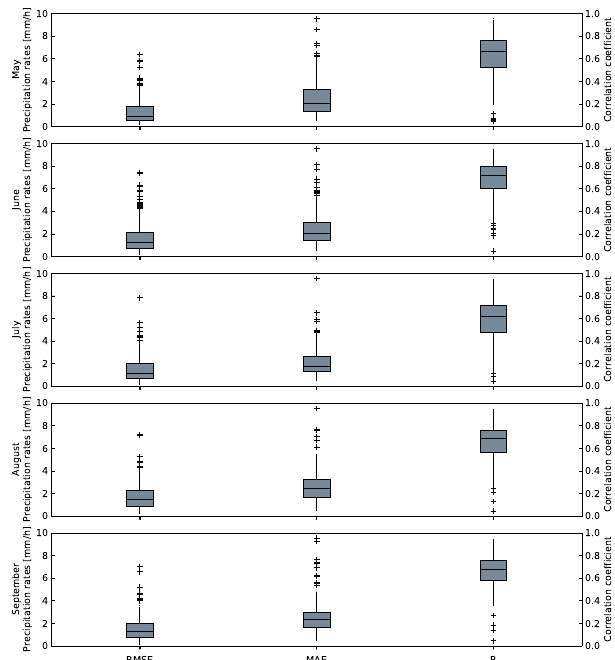
Figure 5. Performance of the validation of predicted precipitation rates against the gauge calibrated MW precipitation rates as boxplots. Validation measures RMSE, MAE (left y -axis) and correlation coefficient R (right y -axis) were calculated for each scene separately and then averaged on a monthly basis. The boxes display the percentiles (25th, 50th, and 75th). The whiskers indicate extreme data up to 1.5 times of the interquartile range. Crosses mark outliers. The width of the boxes is relative to the number of validation